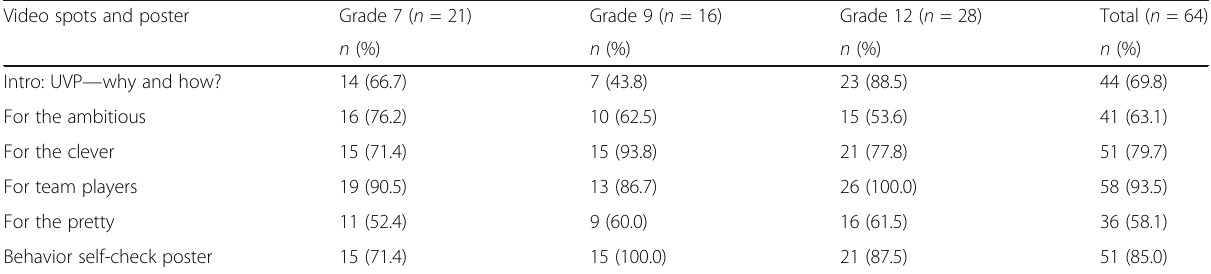
Table 4 Acceptance of materials indicated by frequencies of students that predominately selected positive adjectives ( n = 64) Video spots and poster